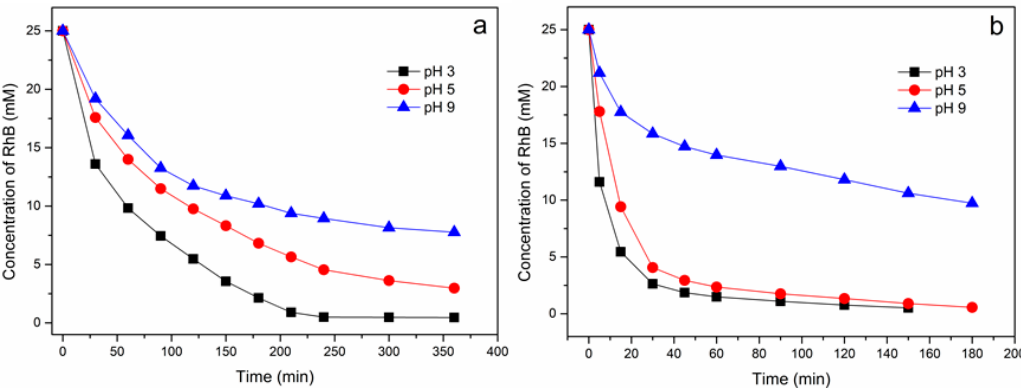
Figure 2. Degradation of RhB in the absence ( a ) and presence ( b ) of HA under various pH conditions. Concentrations: [Schwertmannite] = 0.5 g/L, [RhB] = 25 mM, [PS] = 5 mM, and [HA] = 0.5 mM.